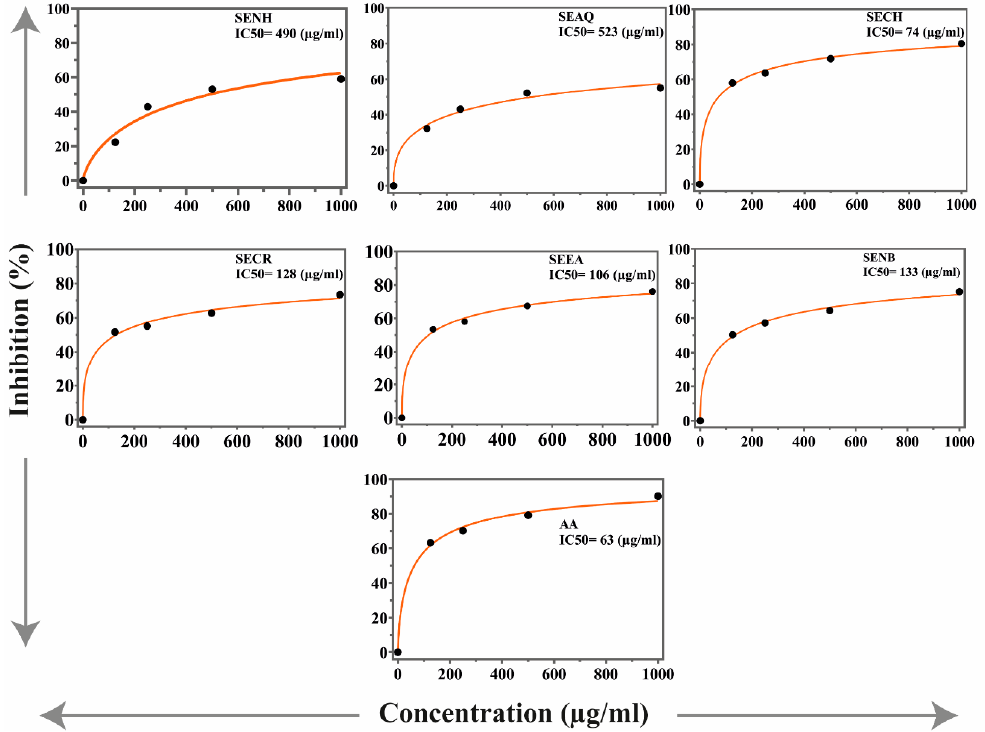
Figure 2. ABTS activities of S. edelbergii extracts. SE, S. edelbergii; NH, n-hexane; AQ, aqueous; CH, chloroform; NB, n-BuOH; EA, EtOAc; CR, crude; AA, ascorbic acid. Data were taken as mean ± SEM and n = 3 with p ≤ 0.01 **.